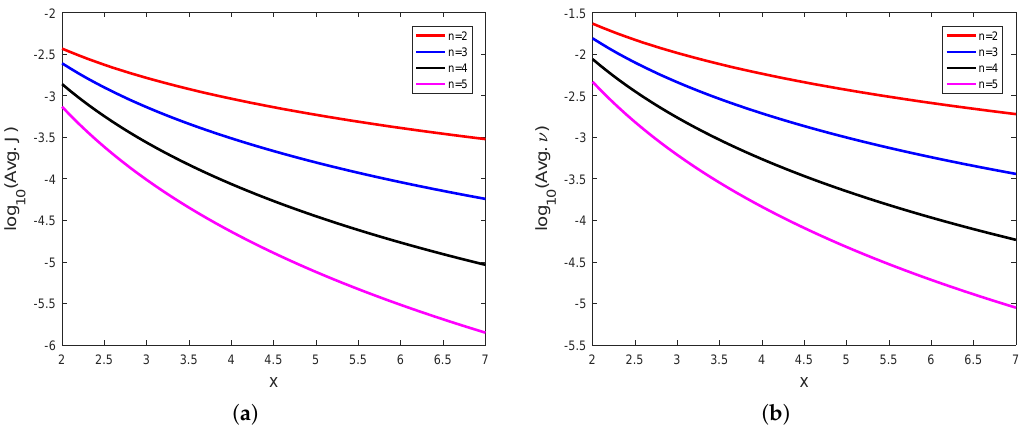
Figure 11. ( a ) Logarithm of Li’s un-normalized MoN (log Li’s normalized MoN (log (Avg. ν )) vs. x using 10 scalar measurements. 10